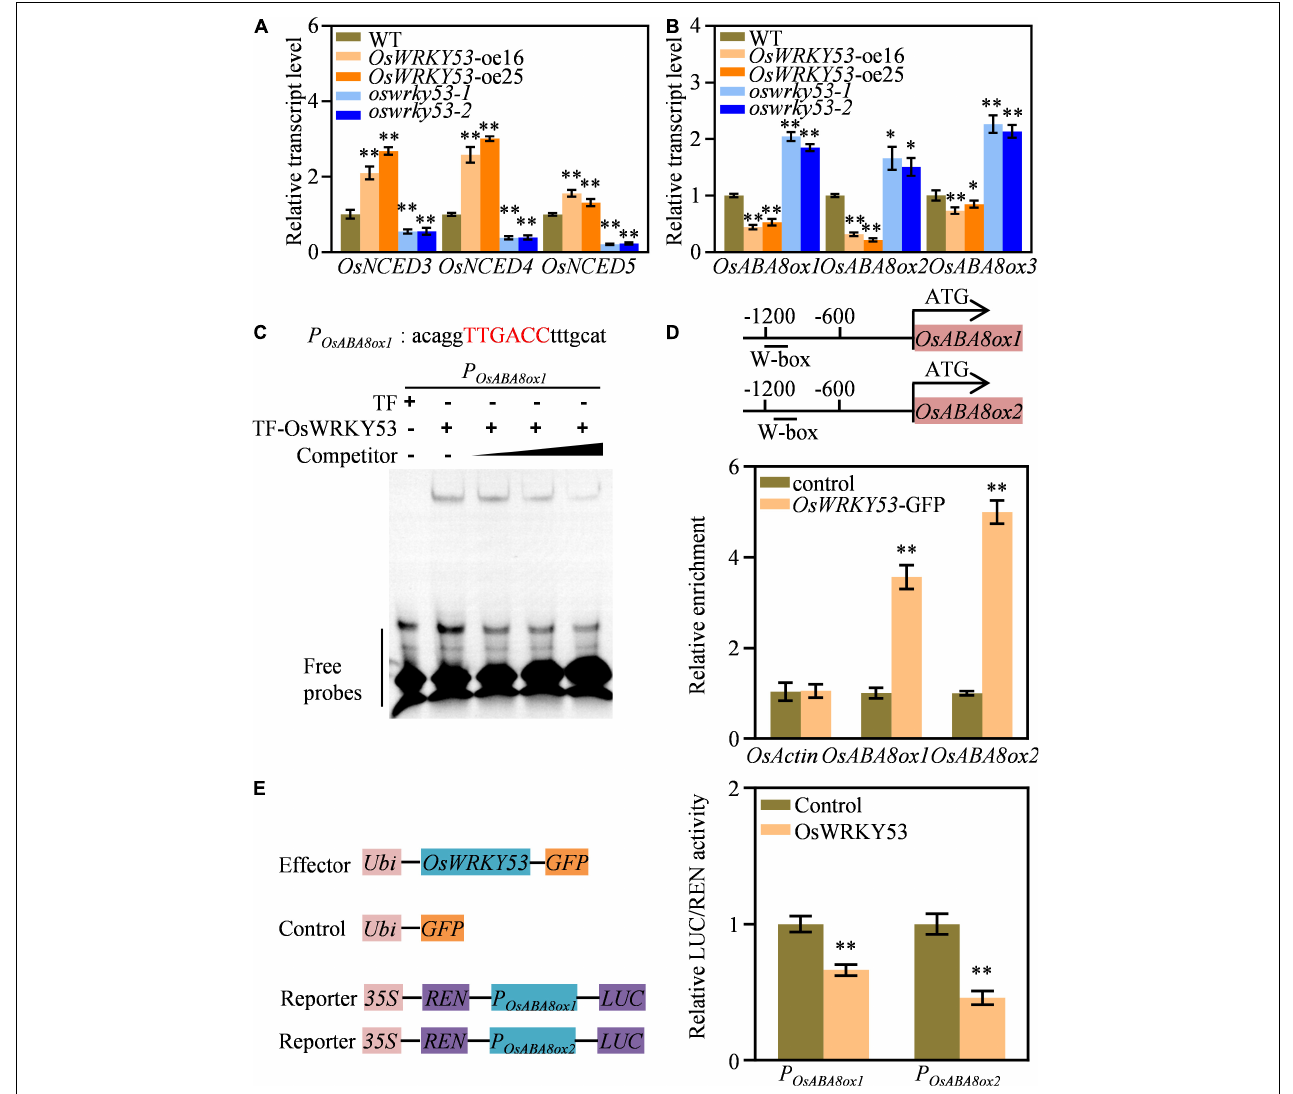
FIGURE 5 | OsWRKY53 binds and downregulates ABA catabolic genes expression. (A) Relative transcript levels of three ABA biosynthetic genes in OsWRKY53 -oe, oswrky53 mutants, and wild type (WT). (B) Relative transcript levels of three ABA catabolic genes in OsWRKY53 -oe, oswrky53 mutants, and WT. (C) DNA-binding activity assay of OsWRKY53 by EMSA. The red capital letters indicate the canonical W-box. (D) Binding assay of OsWRKY53 to the promoters of OsABA8ox1 and OsABA8ox2 by ChIP-qPCR in OsWRKY53 -GFP plants using the anti-GFP antibody. (E) Activity assay of OsWRKY53 in regulating OsABA8ox1 and OsABA8ox2 expression. Data represent mean ± SD. Asterisks indicate a significant difference between transgenic lines and WT determined by two-tailed Student’s t -test at ∗∗ p < 0.01 or ∗ p < 0.05 ( A–C ), or a significant difference between control and effector determined by two-tailed Student’s t -test ∗∗ P < 0.01 (D)